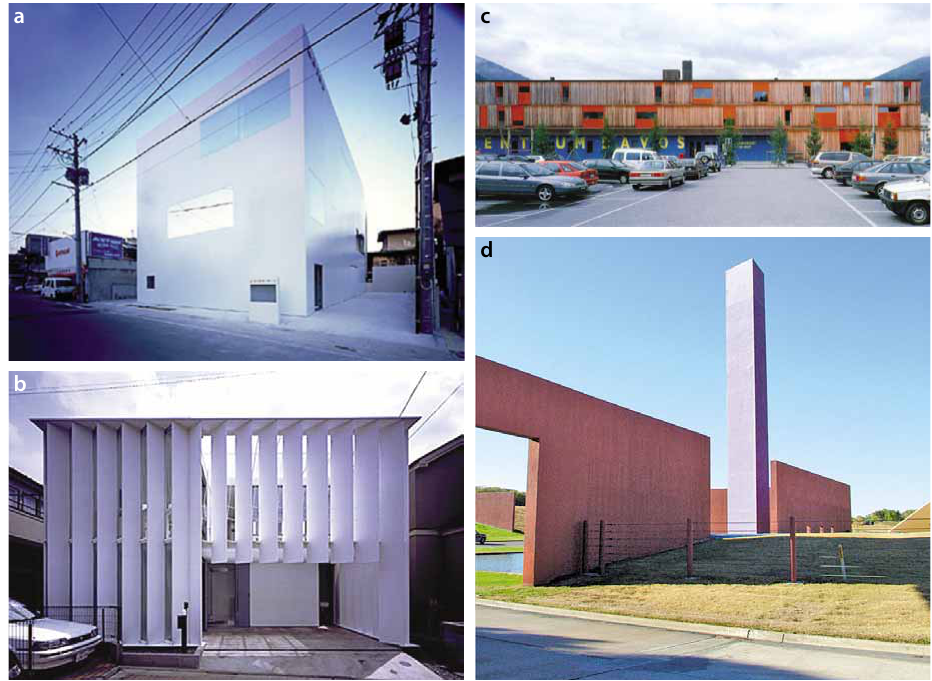
2 pav. Asahi Shinbun pastatas Yamagatoje, Japonija, archit. K. Sejima, 2002 m. (a); Endoh Design House , Tokijus, archit. Masahiro Ikeda, 2002 m. (b); Sporto centras Šveicarijoje, archit. Gigon+Guyer, 2002 m. (c); Solana kompleksas, stela, Southlake, Teksasas, JAV, archit. R. Legorreta, 1991 m. (d) Fig. 2. Asahi Shinbun Building (a). Yamagata, Japan. Archit. K. Sejima, 2002; Endoh Design House (b). Tokyo, Archit. Masahiro Ikeda, 2002; Sports Center (c). Switzerland. Archit. Gigon+Guyer, 2002; Solana Complex (d). Southlake, Texas. Archit. R. Legorreta, 1991